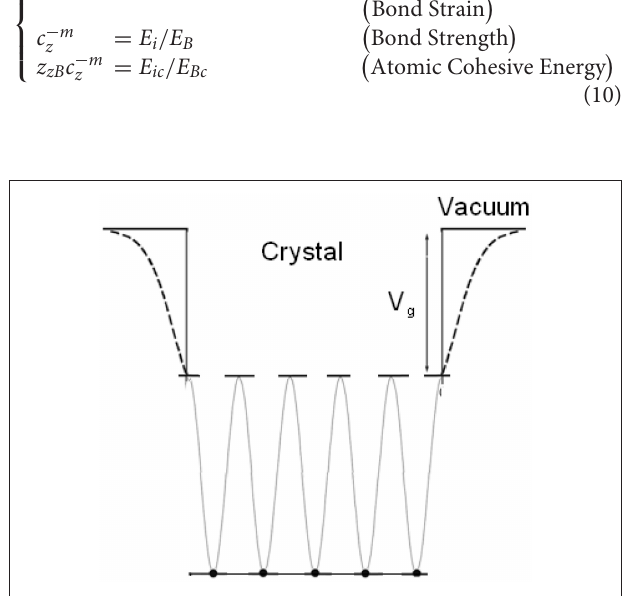
FIGURE 1 | Simplified one-dimensional potential